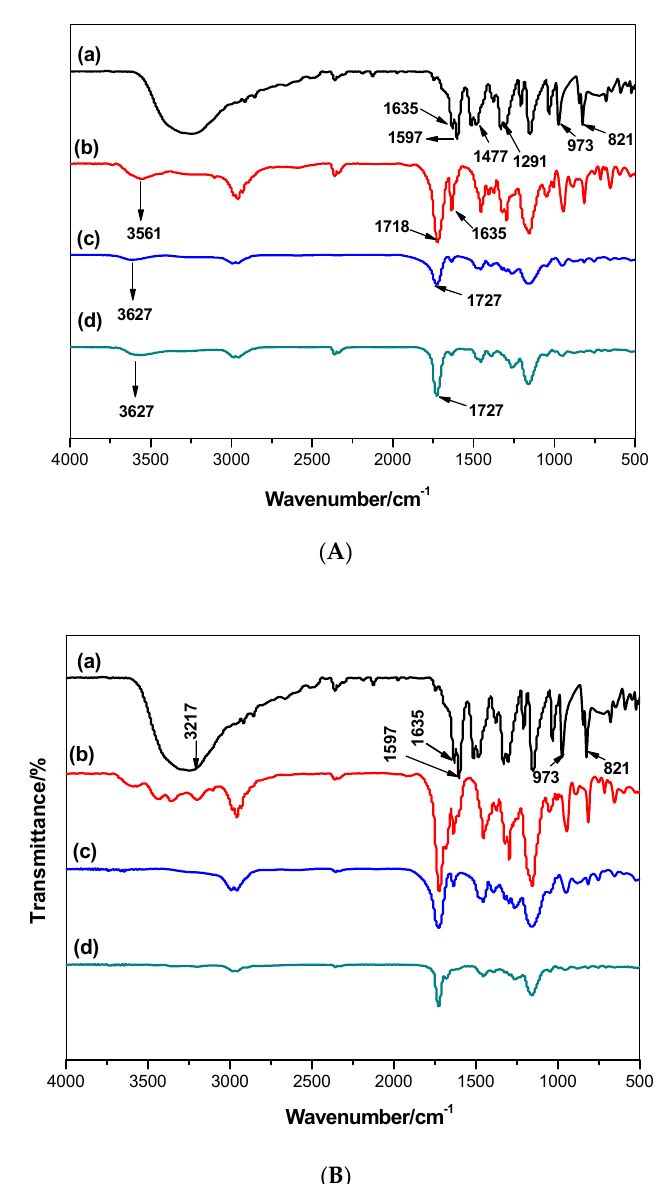
Figure 2. FT-IR spectra of the proposed polymers ( A ) MIP/MAA and ( B ) MIP/AA. ( a ) FT-IR for Orcinol, ( b ) MIP before template removal, ( c ) MIP after template removal, and ( d ) NIP.